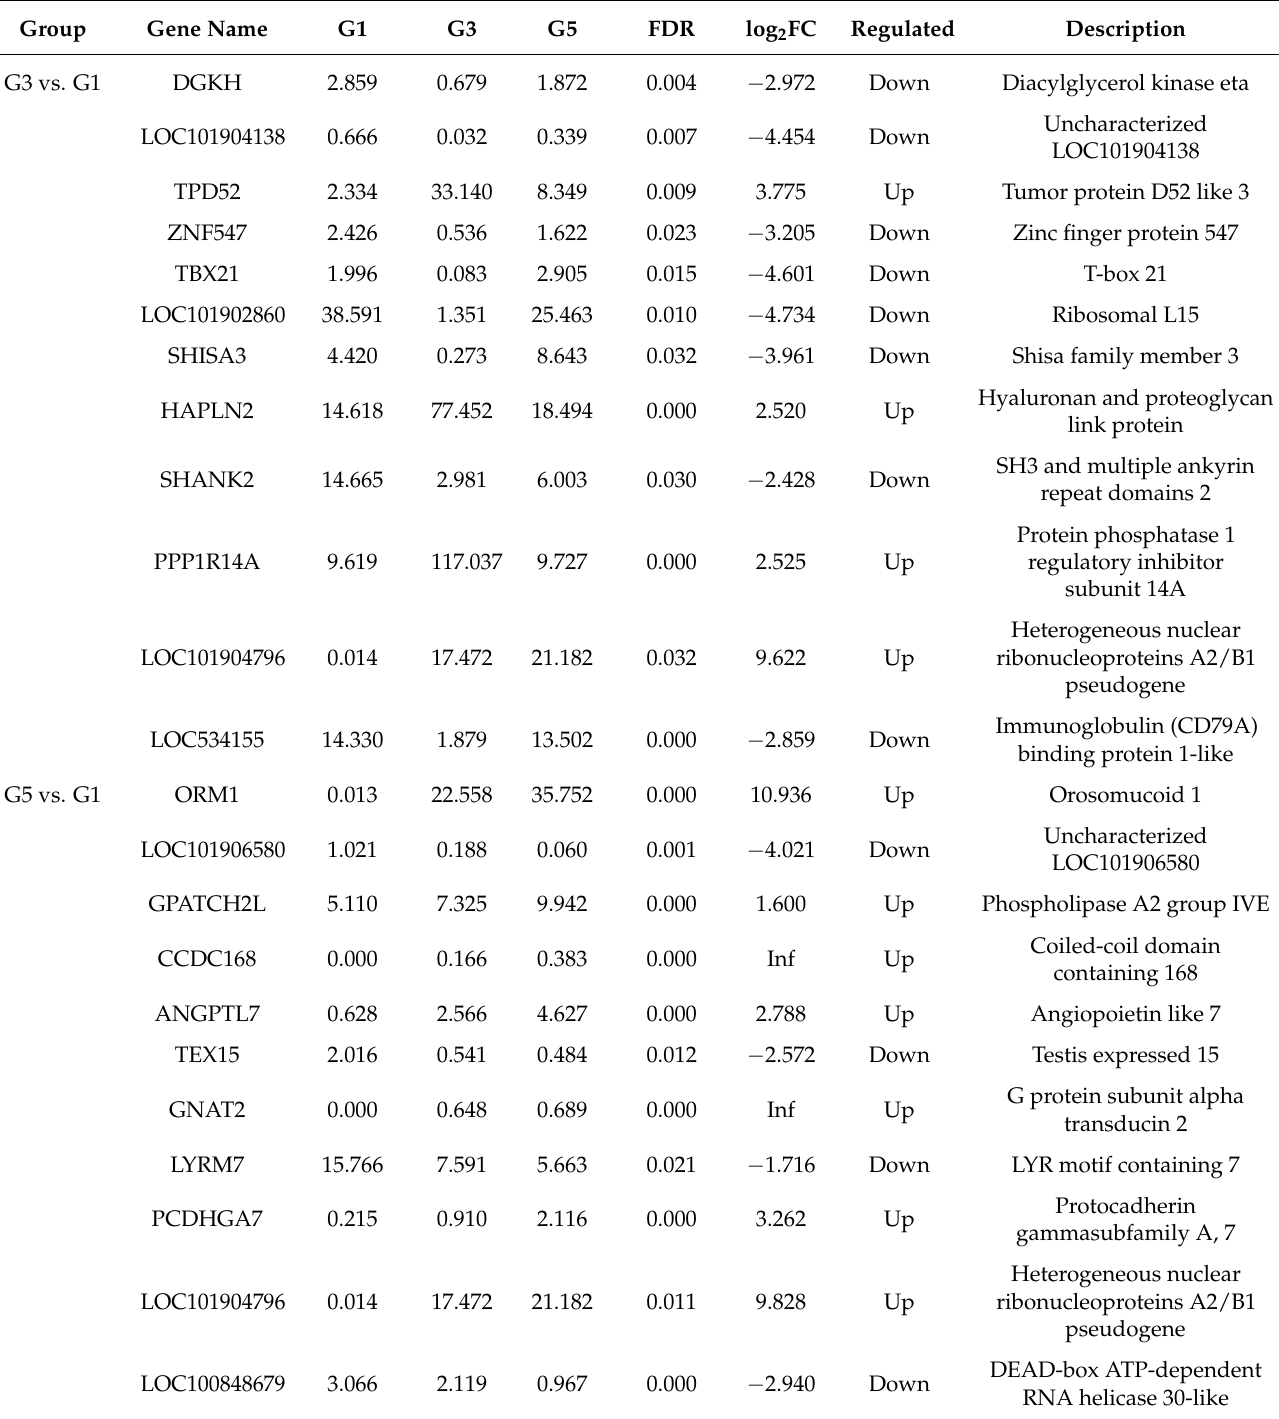
Table 3. Other major differentially expressed genes in pituitary gland (G1, G3, and G5 = 6-month-old, 18-month-old, and 30-month-old Angus cattle